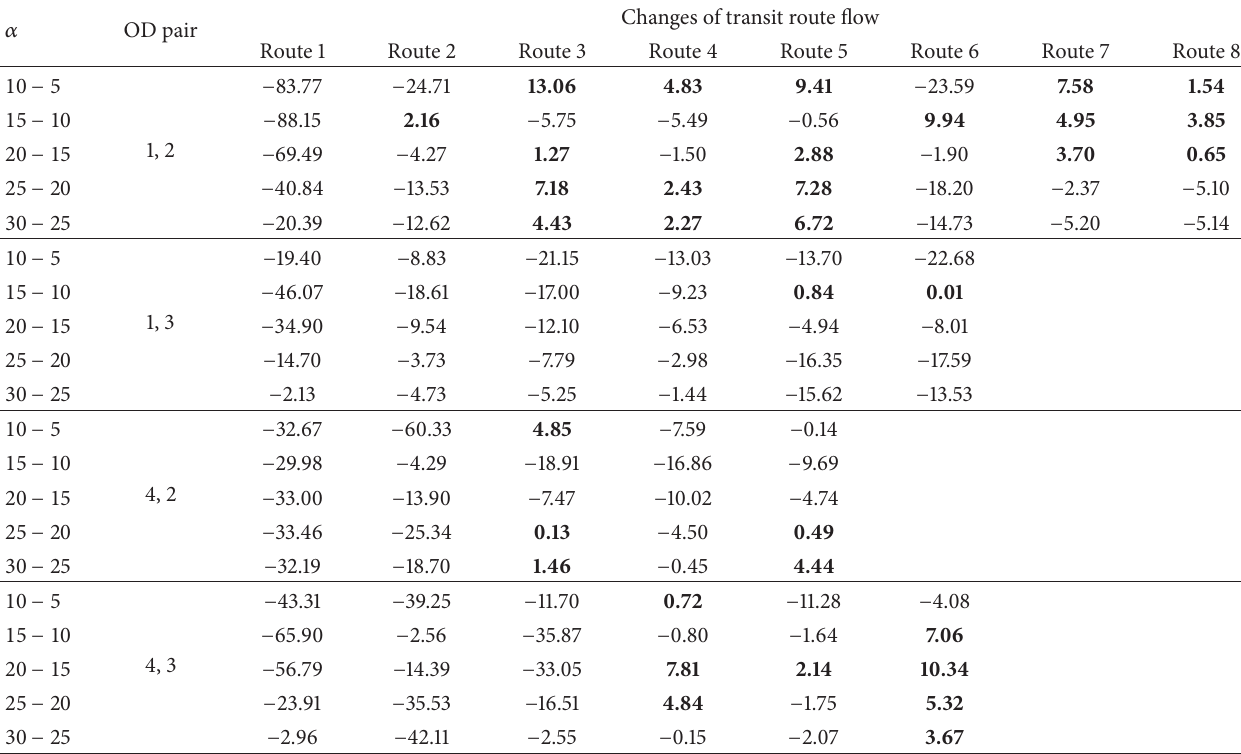
Table 7: The changes of transit route flows considering scenario 1 with different value of